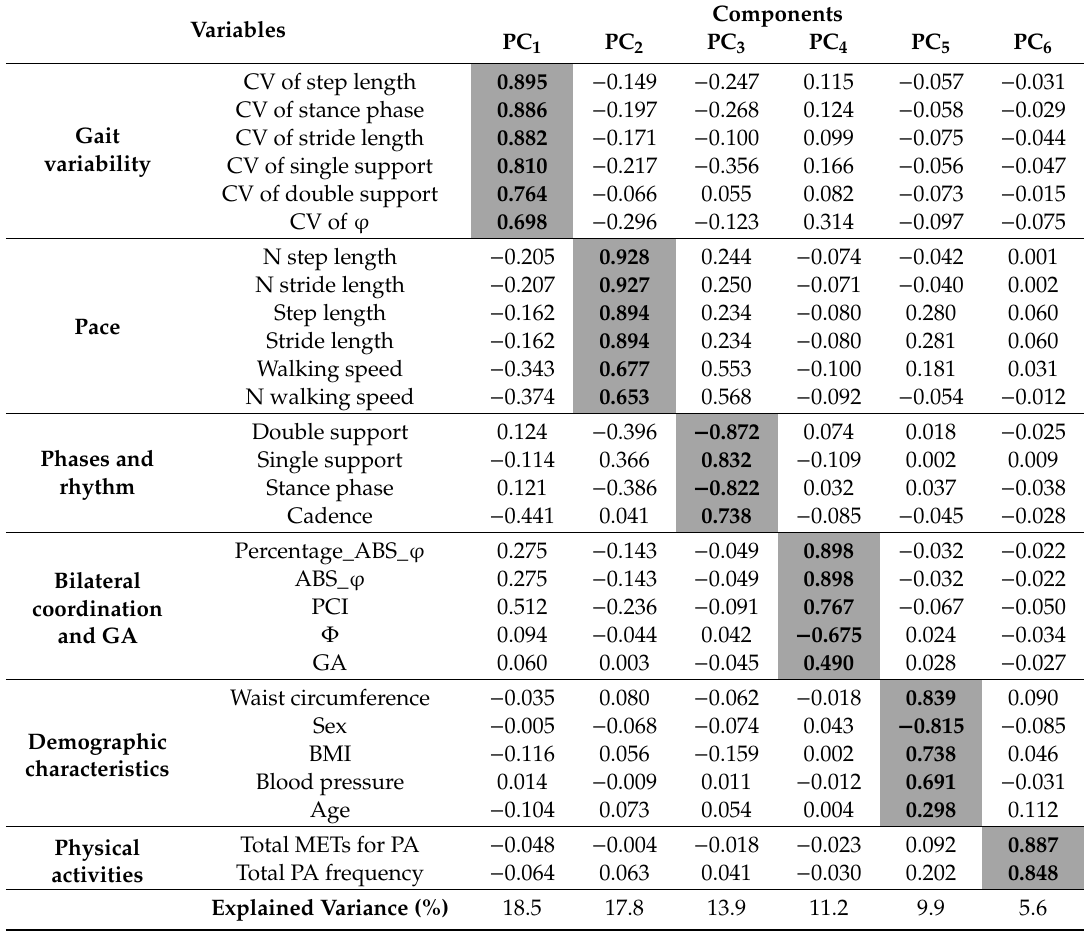
Table 2. Factor loading outcomes for principal